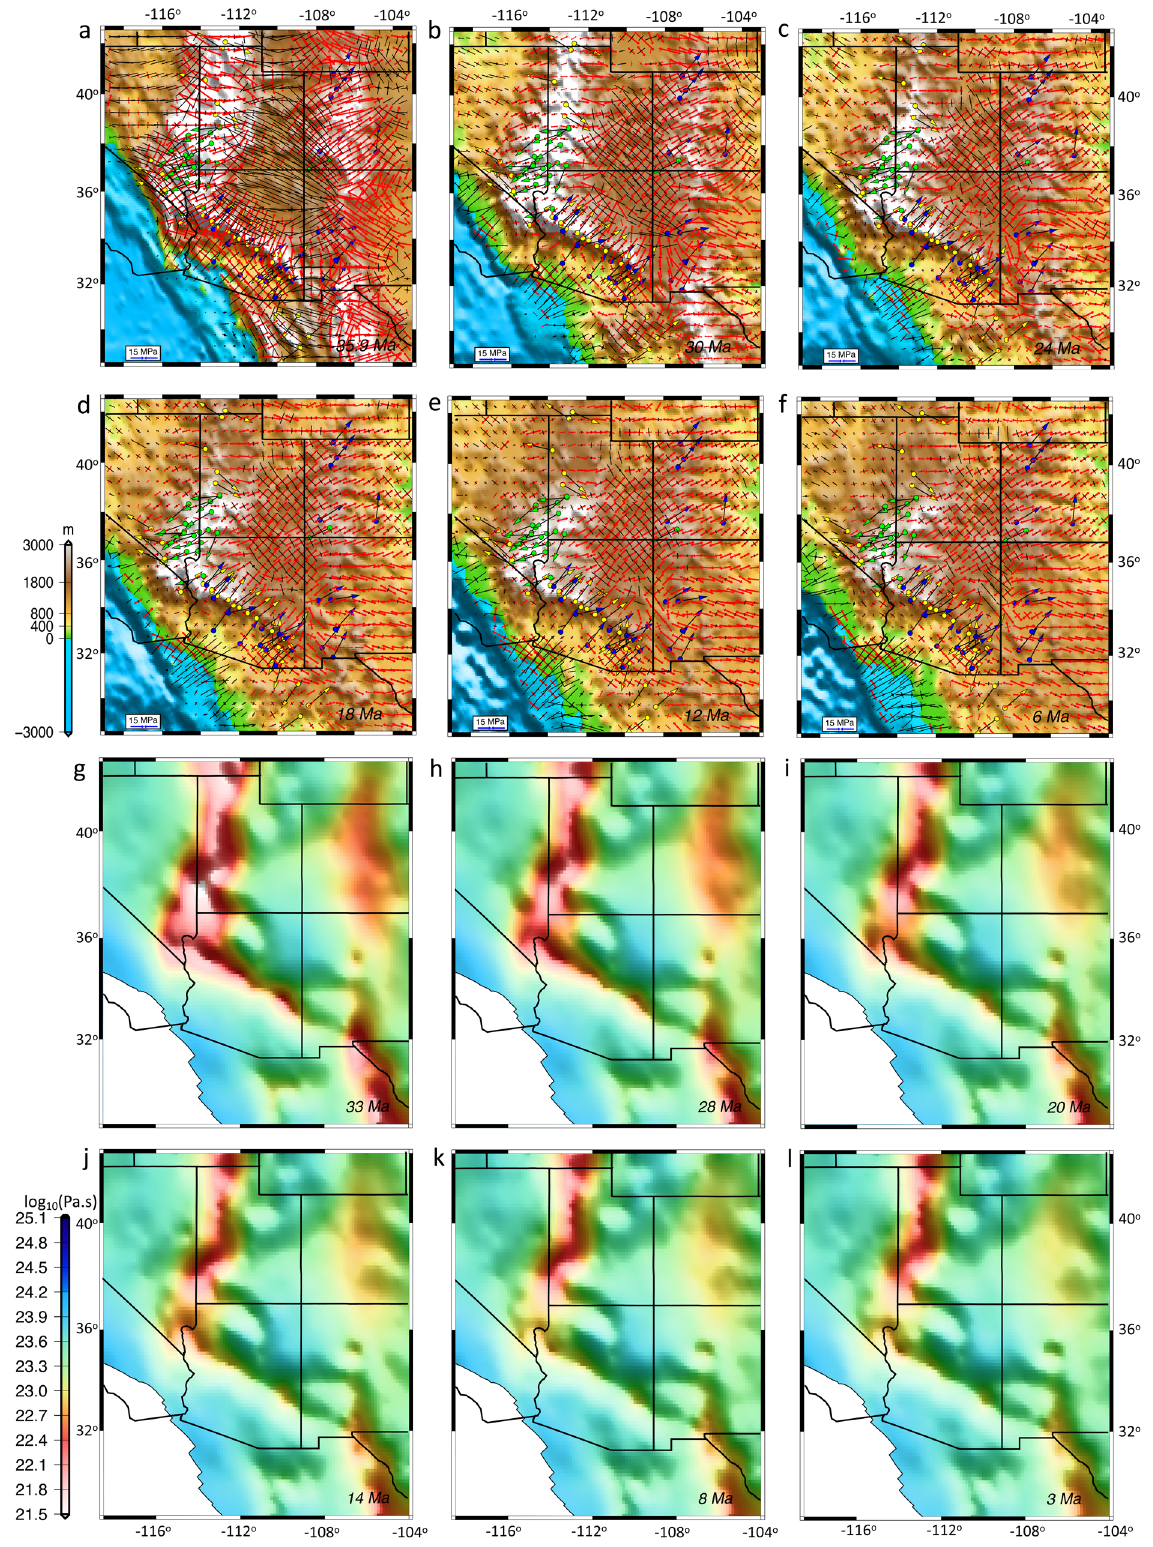
Fig. 9 The evolution of principal axes of deviatoric stresses for the upper crust and effective viscosity within the lithosphere in southwestern North America. a – f Variation of the principal axes of horizontal deviatoric stresses for the upper crust at 35.9, 30, 24, 18, 12, and 6 Ma, respectively. Black arrows represent compressional and red arrows represent tensional stresses. The color-coded circles and vectors represent the stretching direction of metamorphic core complexes shown in yellow and Miocene faults and dykes trend shown in green and blue. g – l Depth averaged effective viscosity of the North American lithosphere, from surface to the base of the lithosphere, at 33, 28, 20, 14, 8, and 3 Ma, respectively. The map images were created by authors using: www.soest.hawaii.edu/gmt/ and www.paraview.org/.